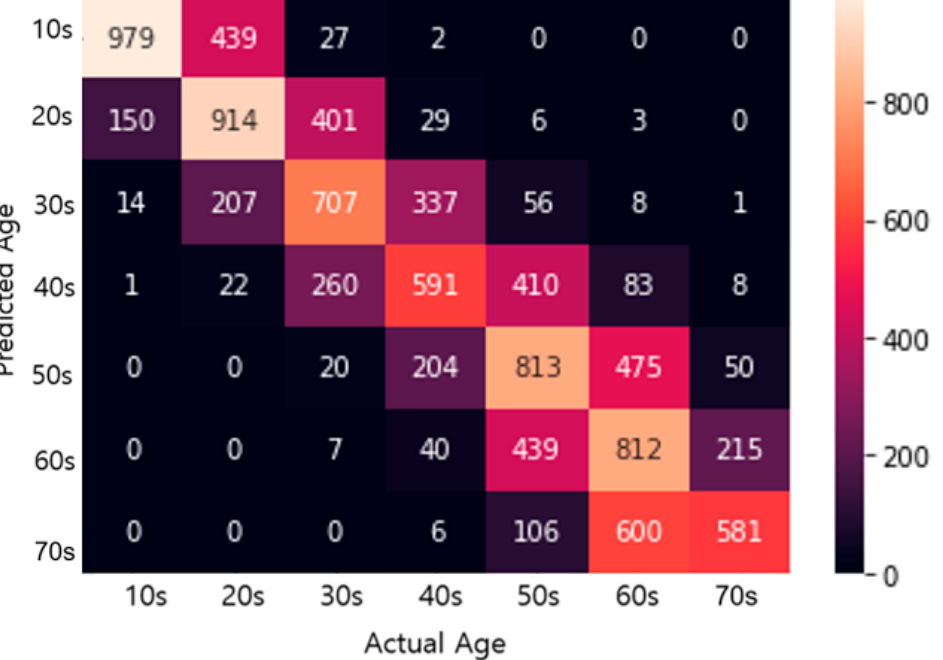
Table 1. Table of accuracies according to tolerances.